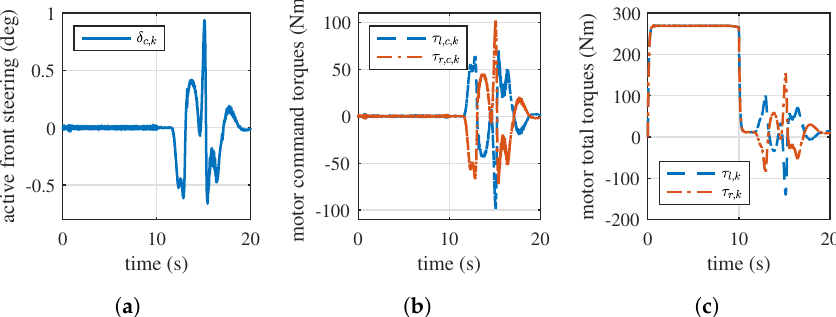
Figure 12. Control actions: active front steering δ c , k , command motor torques τ l , c , k , τ r , c , k and total motor torques τ l , k , τ r , k . ( a ) Control action: active front steering δ c , k . ( b ) Control action: motor command torques. ( c ) Total in–wheel motor torques.